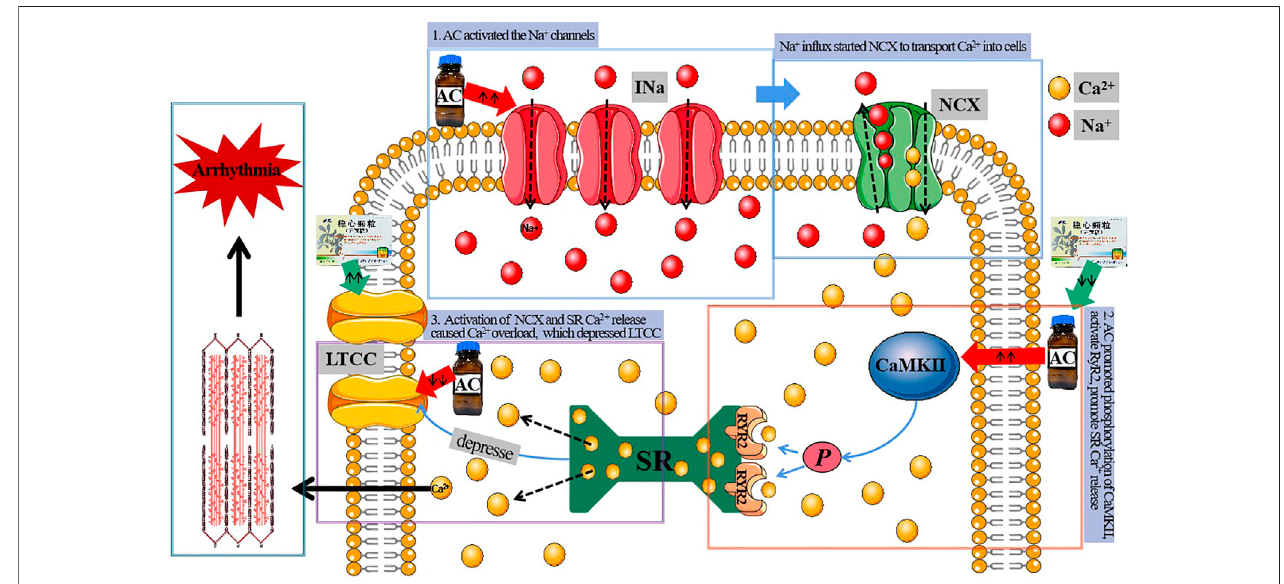
FIGURE 9 | Mechanism of treating arrhythmia with